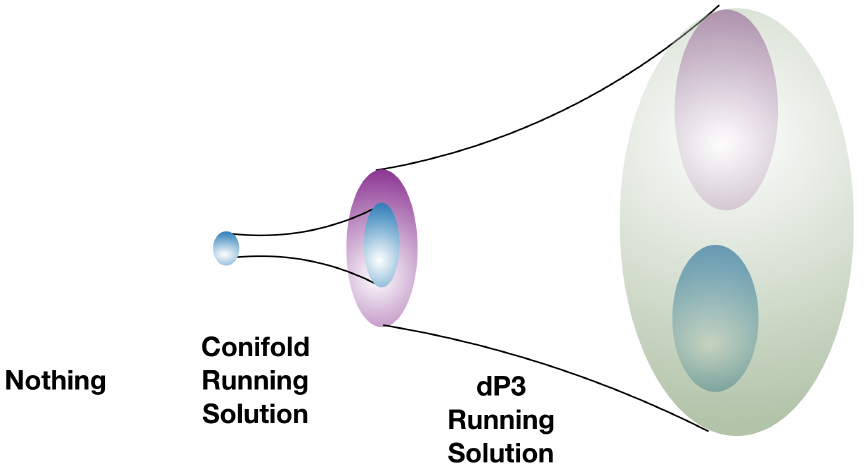
Figure 5 . Domain wall interpolating between the theory on dP 3 with ( M + P ) fractional branes, and a conifold theory with M regular branes and P fractional ones. The running of one of the dynamical tadpoles in the dP theory stops at the wall but the other continues running until it 3 reaches the S 3 at the bottom of the KS